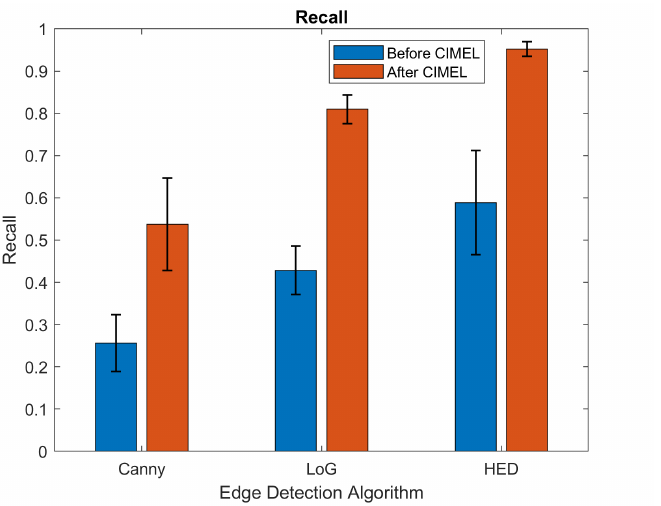
Figure 9. Results of PSNR before and after CIMEL for three edge detection methods.